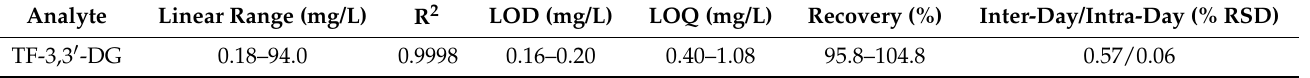
Table 2. Analytical parameters of the developed HPLC method.